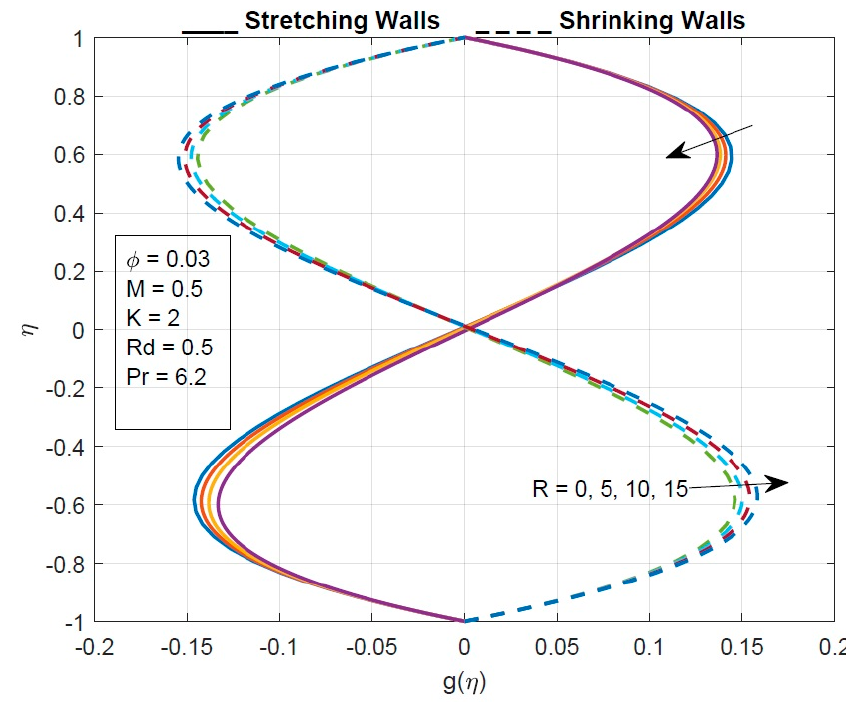
Figure 10. The effect of the Reynolds number on the micro-rotation profile.